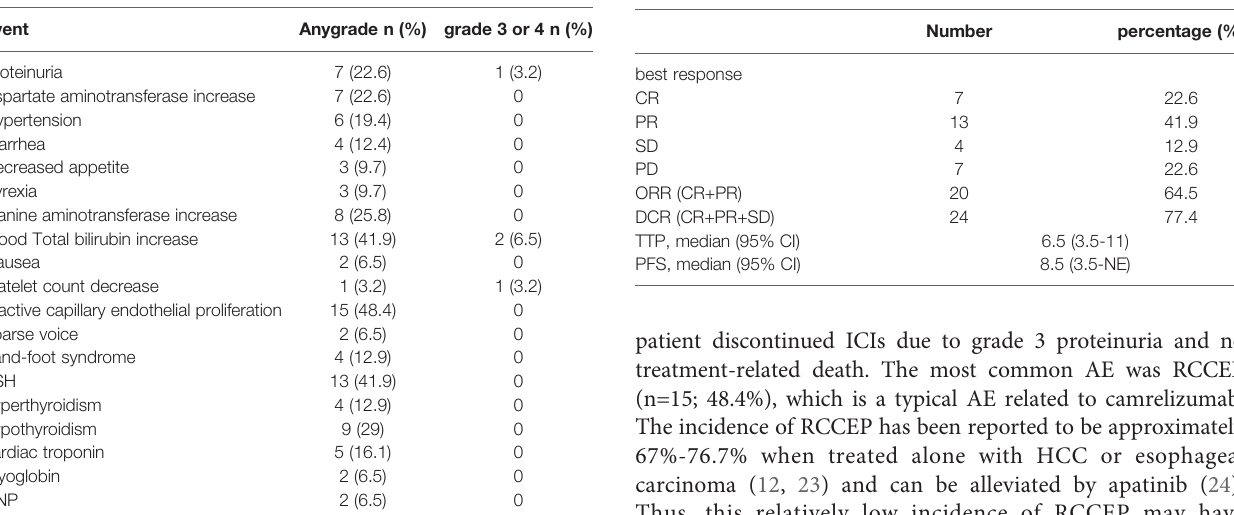
FIGURE 2 | Treatment sequence. Red bar: duration of immunotherapy; ×: time of TACE; blue square; initial time of TKIs. X-axis: months. Y-axis: Patients Nr. TABLE 2 | Adverse events. TABLE 3 | Radiological response according to mRECIST and clinical ef fi